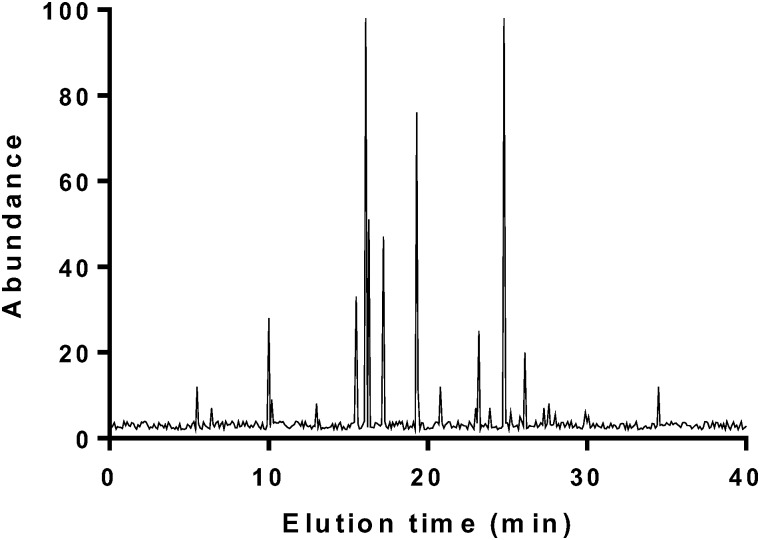
GC analysis of main components of BG.